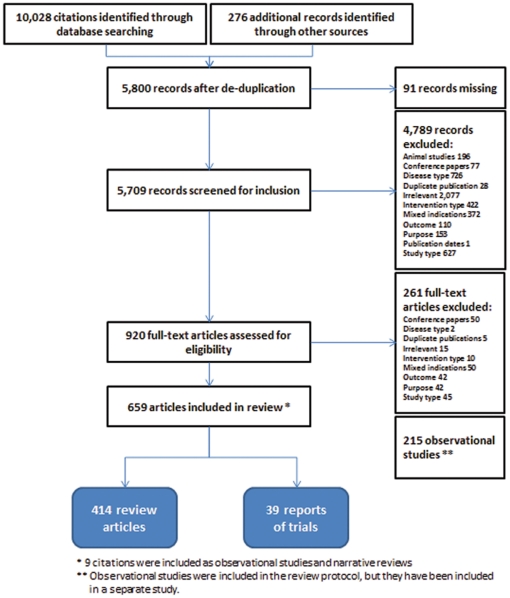
PRISMA flow diagram.